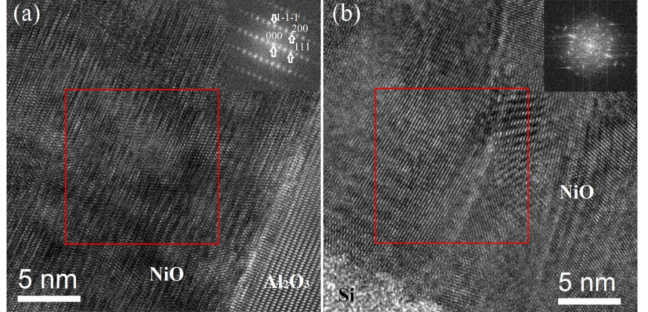
Figure 6. HRTEM images of an epitaxial NiO thin film on Al 2 O 3 substrate ( a ) and polycrystalline thin film on Si substrate ( b ). These films were deposited at the same time. Insets show the FFT patterns of selected regions marked by red